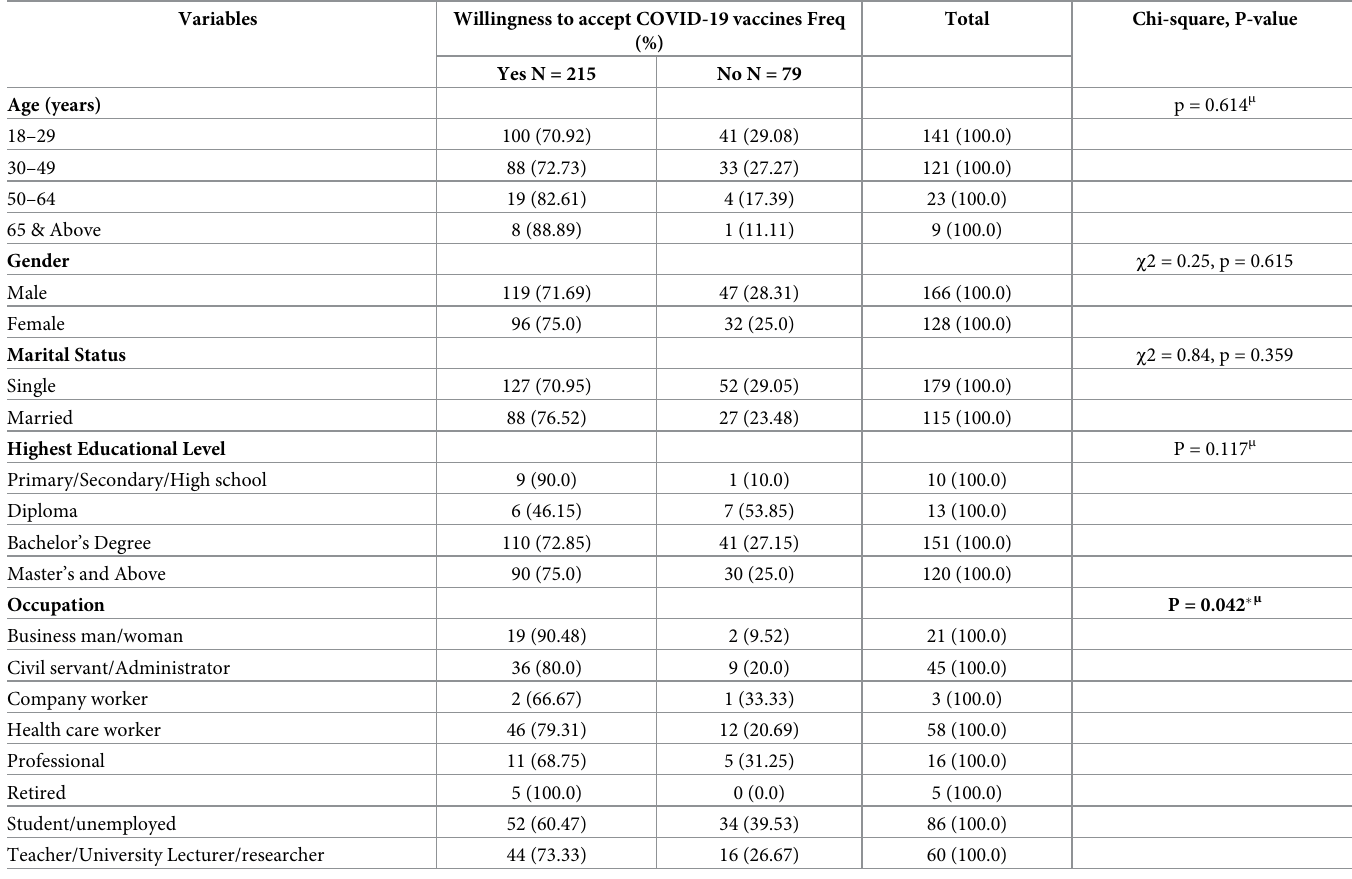
Table 7. Determinants of willingness to accept COVID-19 vaccines (n =